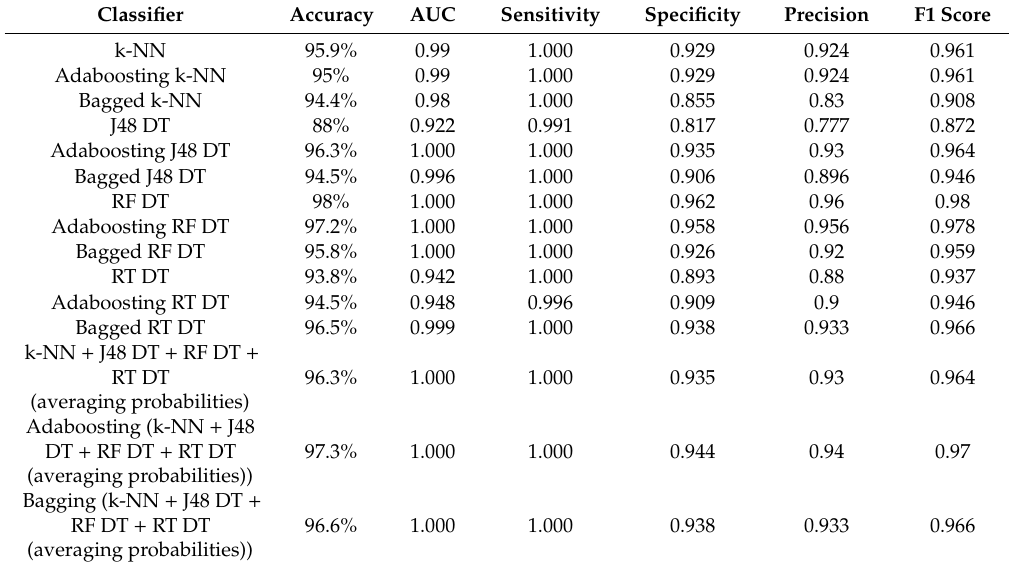
Table 5. The classification results of the four individual classifiers and the MCS constructed with all the four classifiers and their ensembles digital mammography dream challenge dataset.